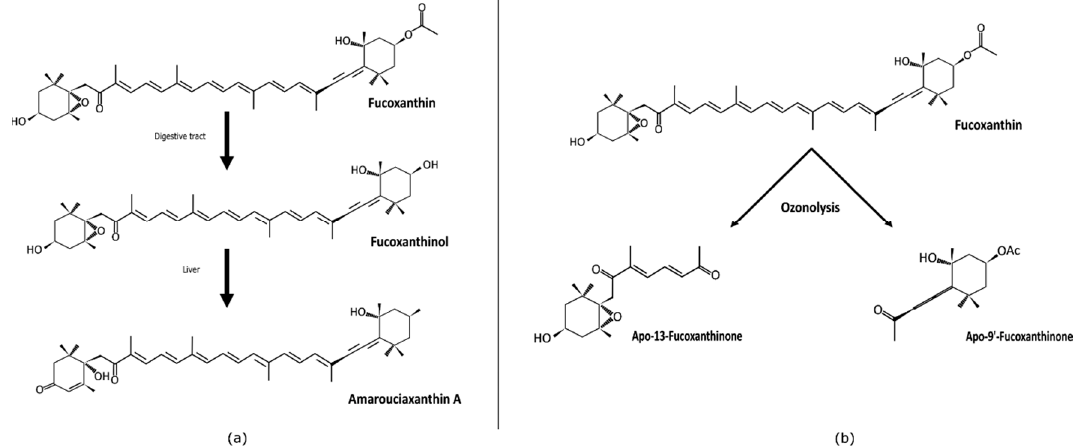
Figure 2. Natural ( a ) and synthetic ( b ) metabolites of fucoxanthin (adapted from Komba et al., 2018 [47]).